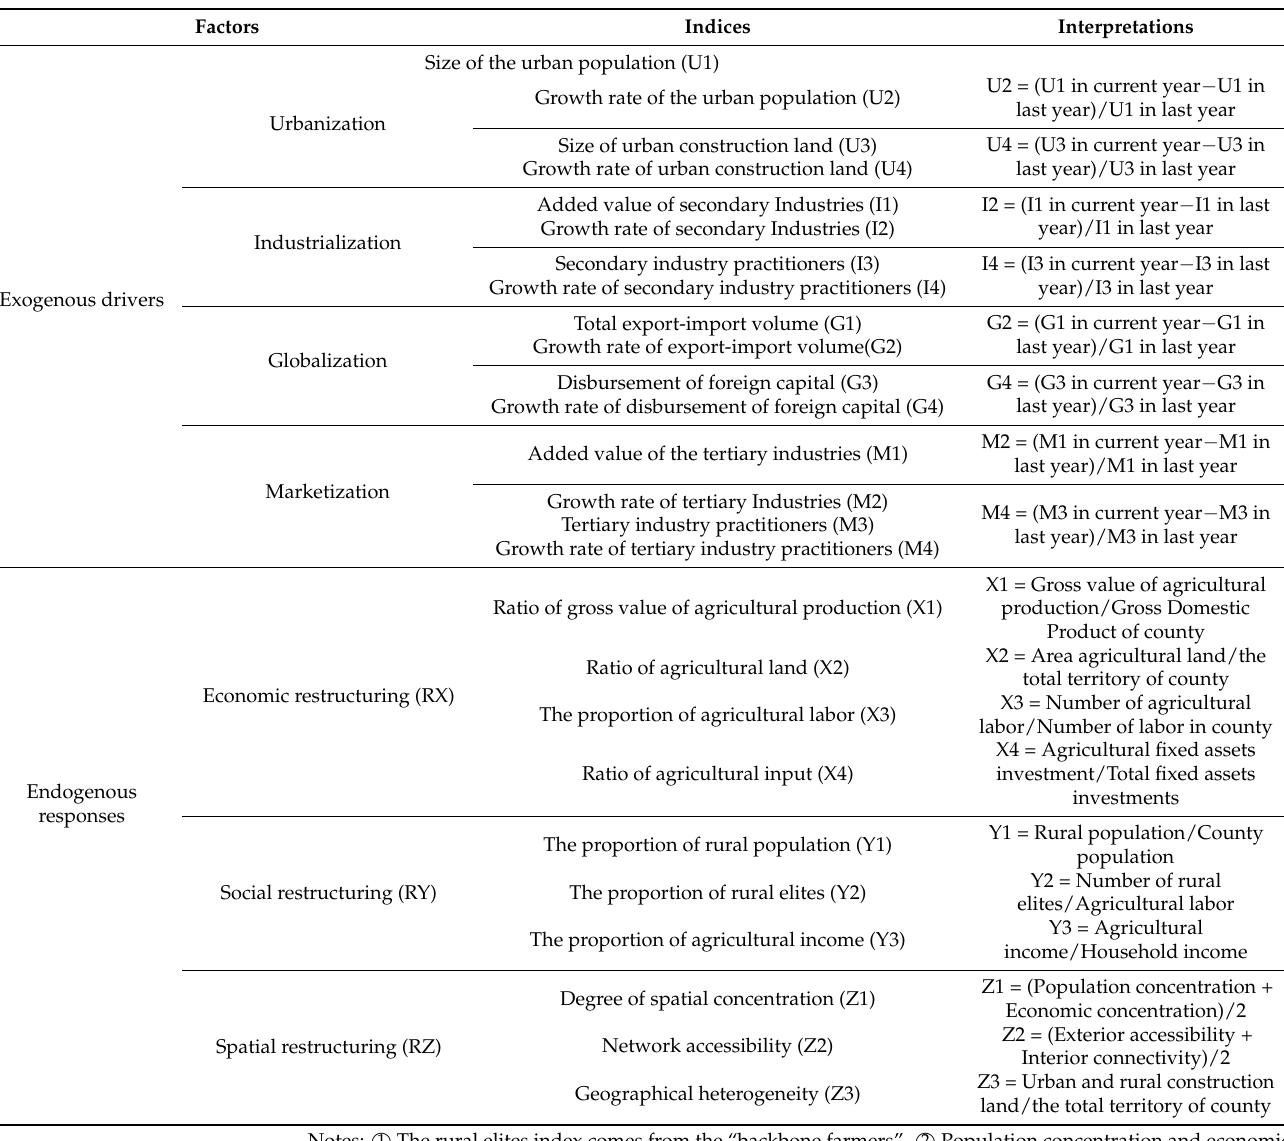
Table 1. Influencing factors of rural transformation: Indexes and